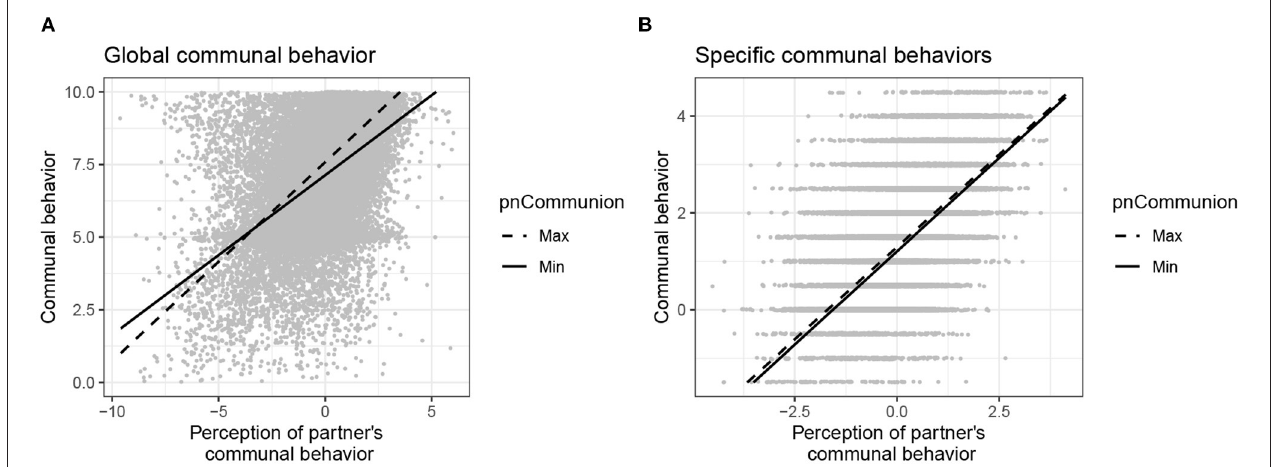
FIGURE 3 | Prediction of communal behavior by the cross-level interaction between individuals’ pnCommunion and their perceptions of their partners’ communal behavior. (A) Global communal behavior. (B) Specific communal behaviors. Figure available at: https://osf.io/2fz5w/ under a CC-BY4.0 license.